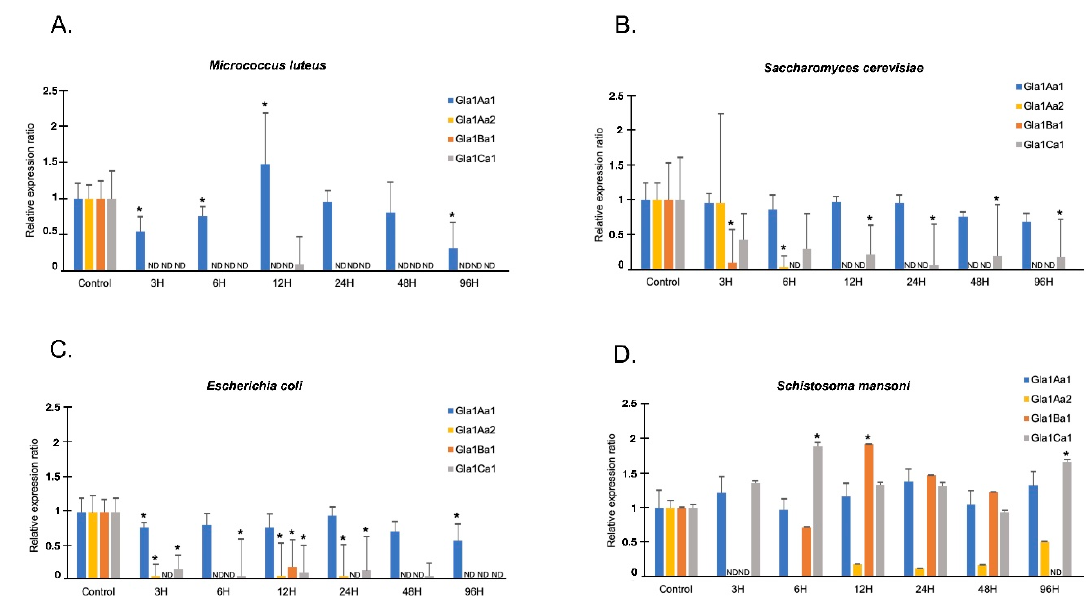
Figure 7. Expression of Glabralysins in response to intruders. Quantitative RT-PCR was performed from whole snails exposed to different pathogens or unexposed. Glabralysin expression was monitored at six time points (3, 6, 12, 24, 48, and 96 h) with Micrococcus luteus ( A ), Saccharomyces cerevisiae ( B ), Escherichia coli ( C ), and Schistosoma mansoni ( D ). Glabralysin (Gla1Aa1 (Blue), Gla1Ba1 (orange), Gla1Ca1 (grey), and Gla1Aa2 (yellow)) expression was normalized to S19 housekeeping gene expression and compared with the expression obtained in non-exposed snails. Non detected transcript is indicated by ND; error bars represent the SD of the relative quantification values obtained for each point. The significant difference in Glabralysins expression was evaluated according to a Mann Whitney U test. The asterisks indicate a significant difference between non-exposed and exposed snails.